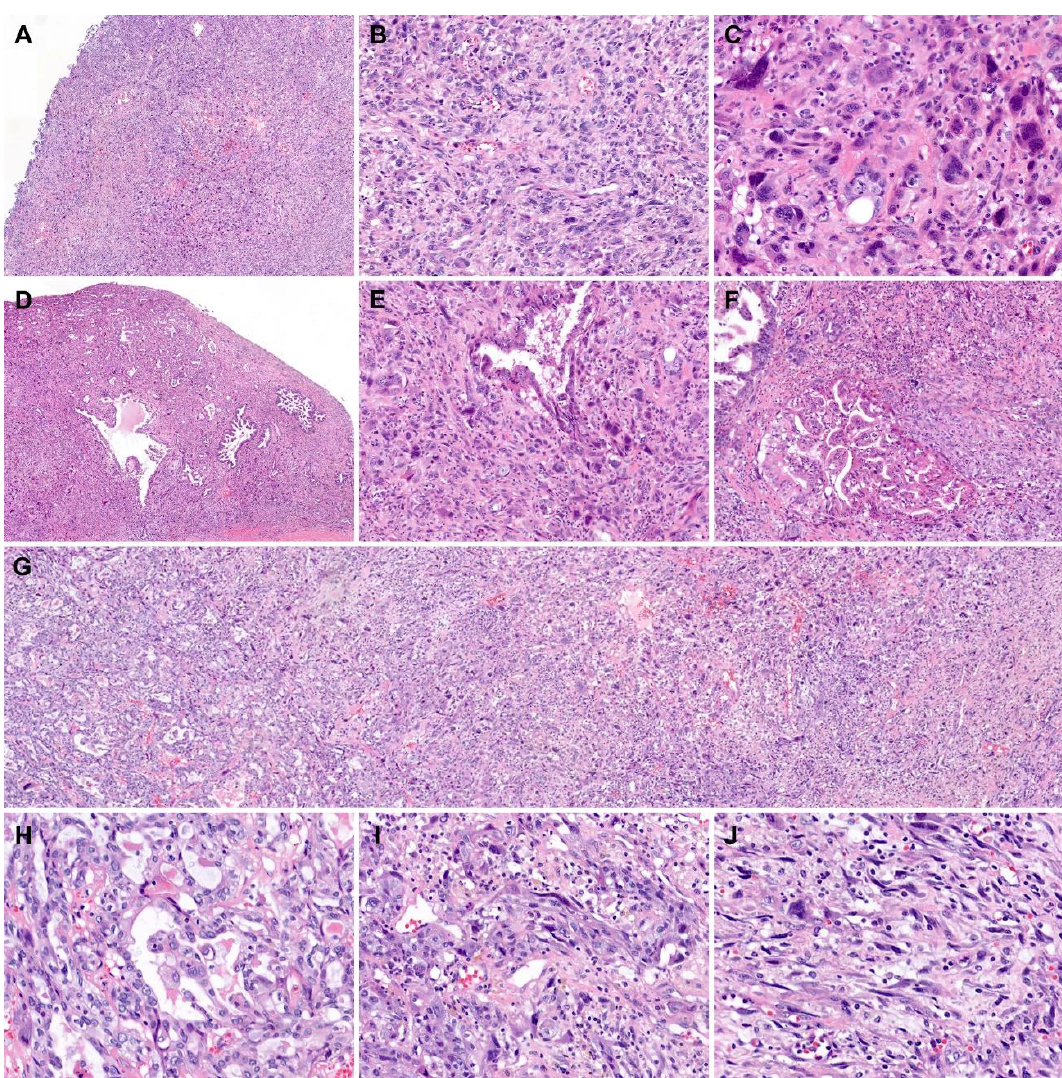
Figure 3. Histological features of mural nodules associated with retroperitoneal mucinous carcinoma. ( A ) The mural nodules showed a di ff use proliferation of pleomorphic tumor cells, forming large, solid cellular sheets. ( B ) The spindle-shaped or polygonal tumor cells were arranged haphazardly. ( C ) Bizarre or multinucleated tumor cells were noted. ( D ) In some areas, variably sized, irregularly shaped glands were randomly distributed within the sarcomatous component. ( E ) An angulated tumor gland was embedded within the sarcomatous component. ( F ) Two large glands, which showed a complex, cribriform architecture, were present. ( G – J ) Sarcomatous transformation. The carcinomatous component displayed ( H ) a moderately di ff erentiated adenocarcinoma (left one-third of image G ) transformed through ( I ) a poorly di ff erentiated carcinoma (middle one-third of image G ) into ( J ) a sarcoma (right one-third of image G ). Staining method: ( A – J ), hematoxylin and eosin. Original magnification: ( A ), 10 × ; ( B ), 100 × ; ( C ), 400 × ; ( D ), 10 × ; ( E ), 100 × ; ( F , G ), 40 × ; ( H – J ), 200 ×